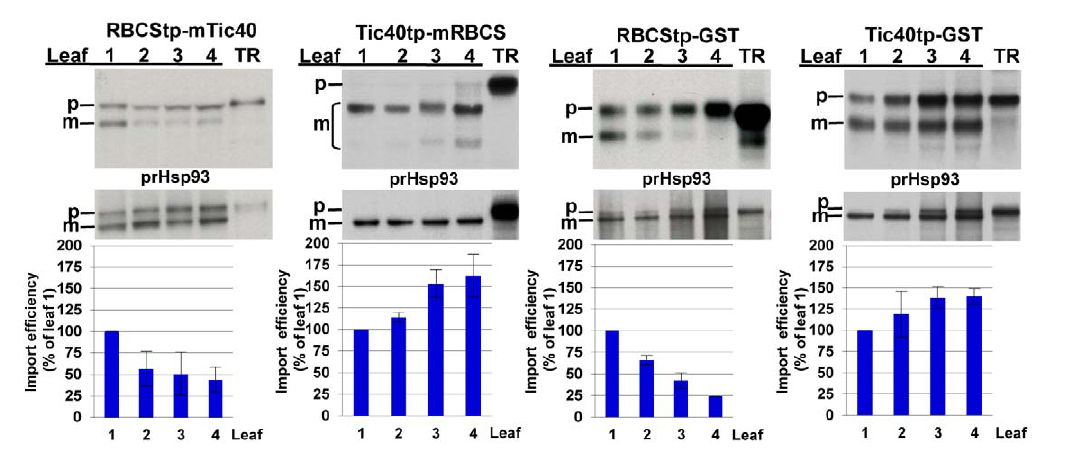
Figure 2. Age selectivity is determined by the transit peptide. Chimeric precursors consisting of swapped prRBCS and prTic40 transit peptides (RBCStp-mTic40 and Tic40tp-mRBCS), or prRBCS or prTic40 transit peptide fused to GST (RBCStp-GST and Tic40tp-GST), were co-imported with prHsp93 into chloroplasts of different ages. Chloroplasts from Tic40tp-mRBCS import experiments were further treated with thermolysin after the import reactions. The amount of mature Hsp93 imported in the same sample was used for normalization in quantifications shown in the bar graph below each gel. The amount of mature proteins imported in leaf 1 was set as 100%. Data shown are means 6 SD, n =3. m, mature form; p, precursor form; TR, in vitro–translated precursor proteins before